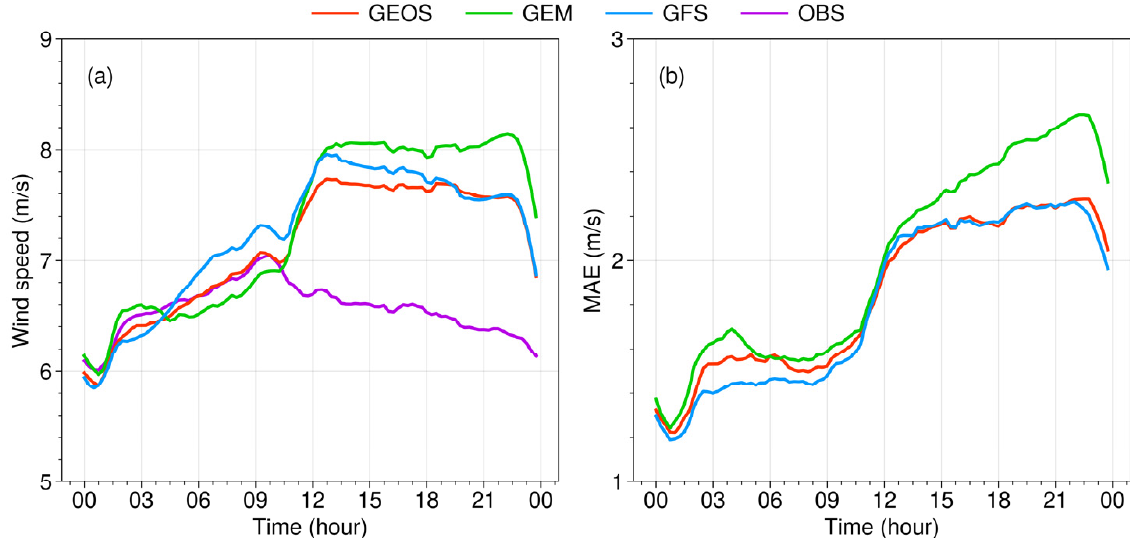
Figure 5. ( a ) Diurnal variation in wind speed observations and forecasts, and ( b ) MAE of the ensemble groups driven by the GFS, GEOS, and GEM. The x-axis represents the time (UTC).